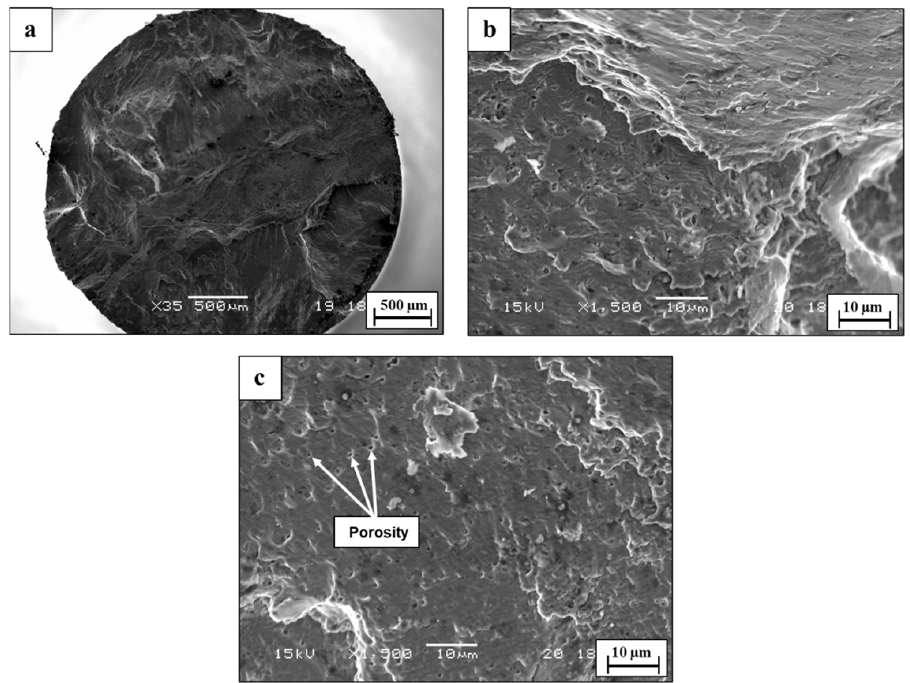
Figure 12. Fractography analysis of WLAM 316L alloy in 3.5% NaCl solution (S = 250 MPa, N = 225,722) ( a ) General view ( b , c ) close-up view.